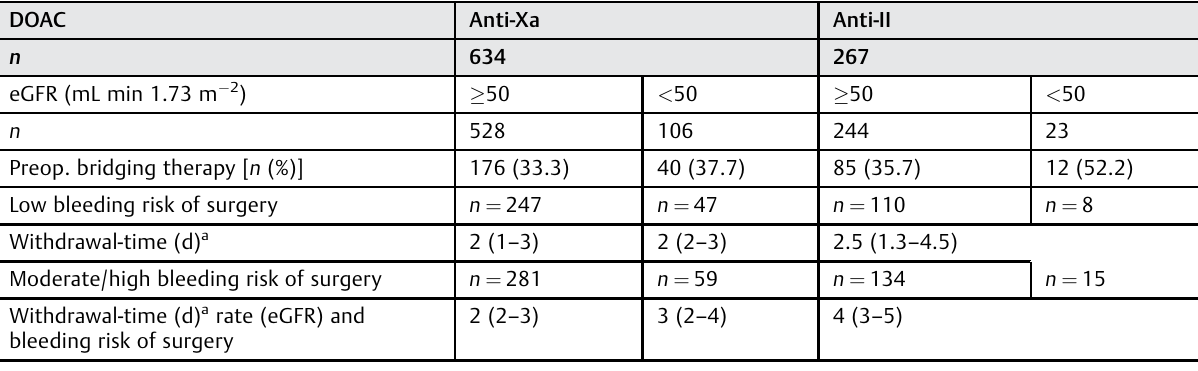
Table 3 Preoperative DOAC-withdrawal time related to estimated glomerular fi ltration rate (eGFR) and bleeding risk of surgery DOAC Anti-Xa